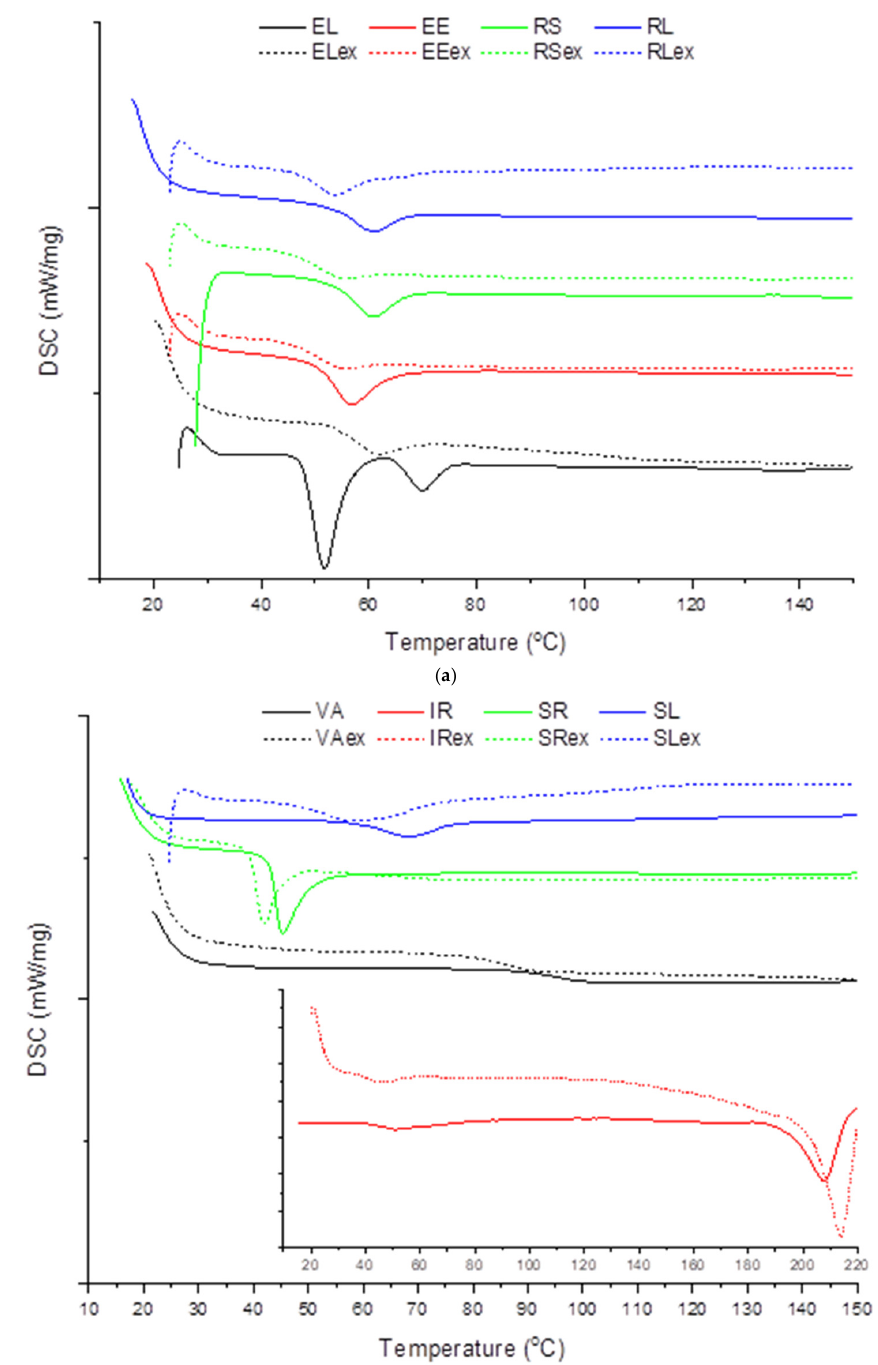
Figure 3. Differential scanning calorimetry (DSC) thermographs of neat and extruded methacrylic ( a ) and polyvinyl ( b )